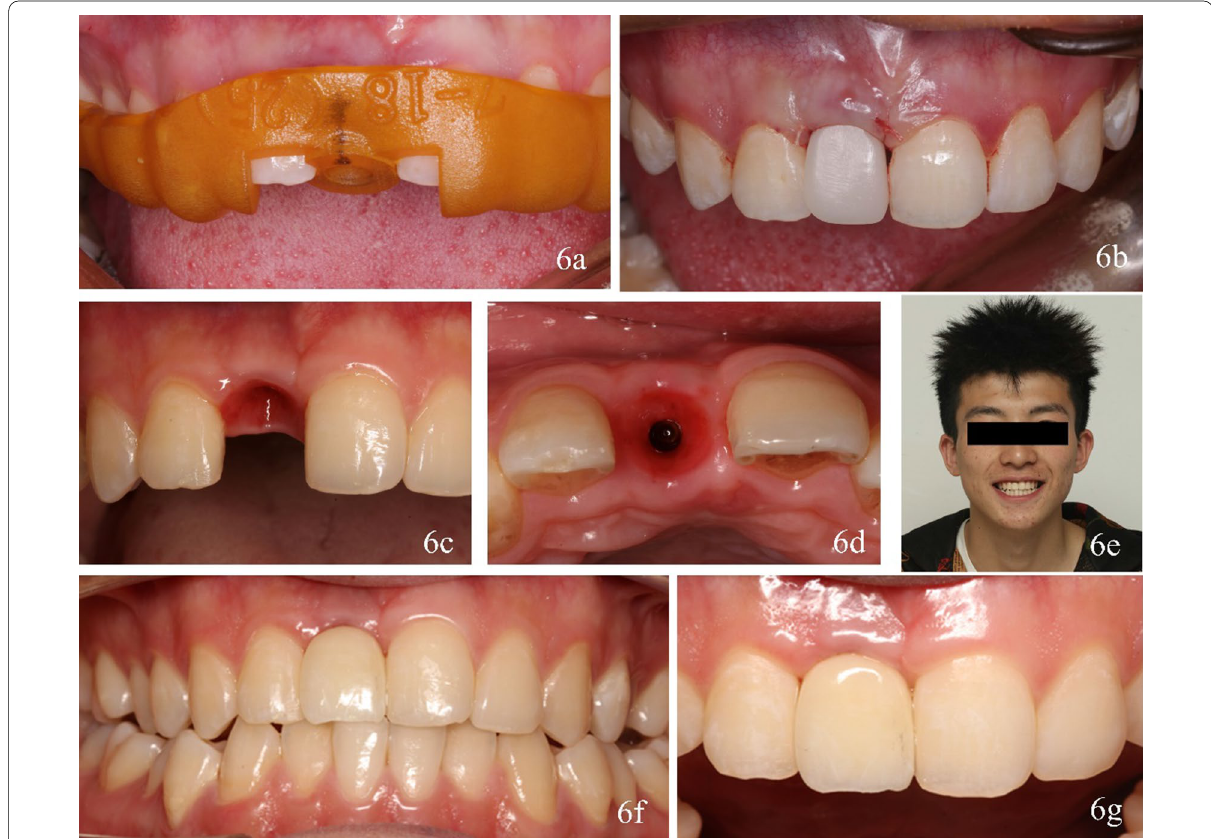
Fig. 6 Implant surgery, ( a ) surgical guide seated. b Placement of immediate interim restoration after implant surgery. Soft-tissue emergence profiles 3 months after placement, c frontal view, d occlusal view. Definitive crown seated, e facial view of the patient. f – g Frontal view of the final